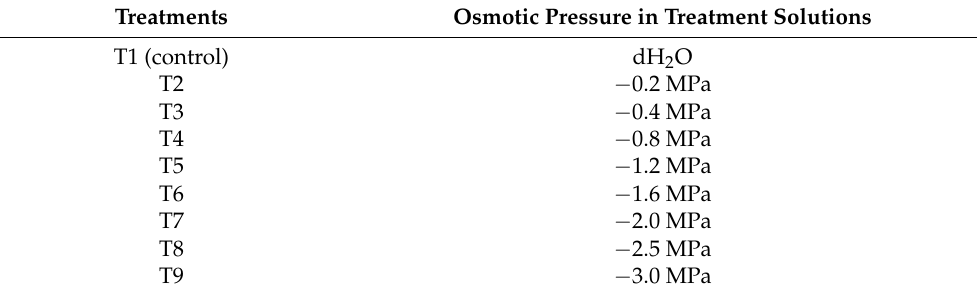
Table 1. Osmotic pressure in treatment solutions used in the experiment for the seed germination of three winter savory natural populations. Osmotic pressure was produced using polyethylene glycol (PEG 6000) [25].